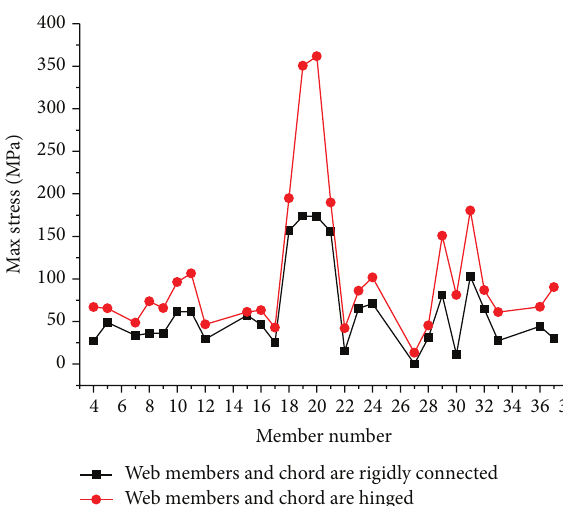
Figure 9: Stress-strain curve.